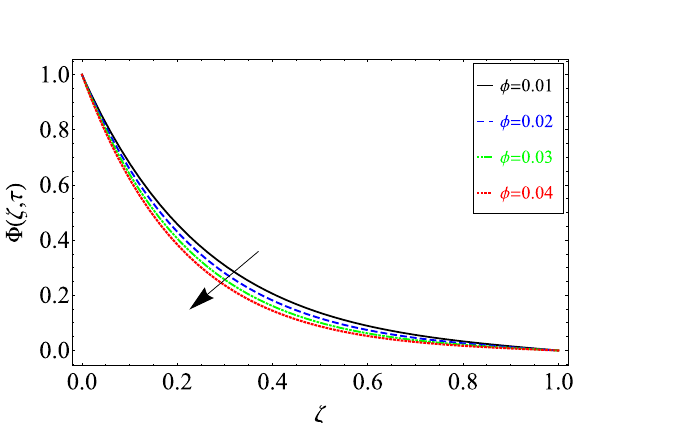
Figure 11. The effect of different values of α on concentration distribution of Maxwell nanofluid, when φ = 0.02 and Sc = 20 .